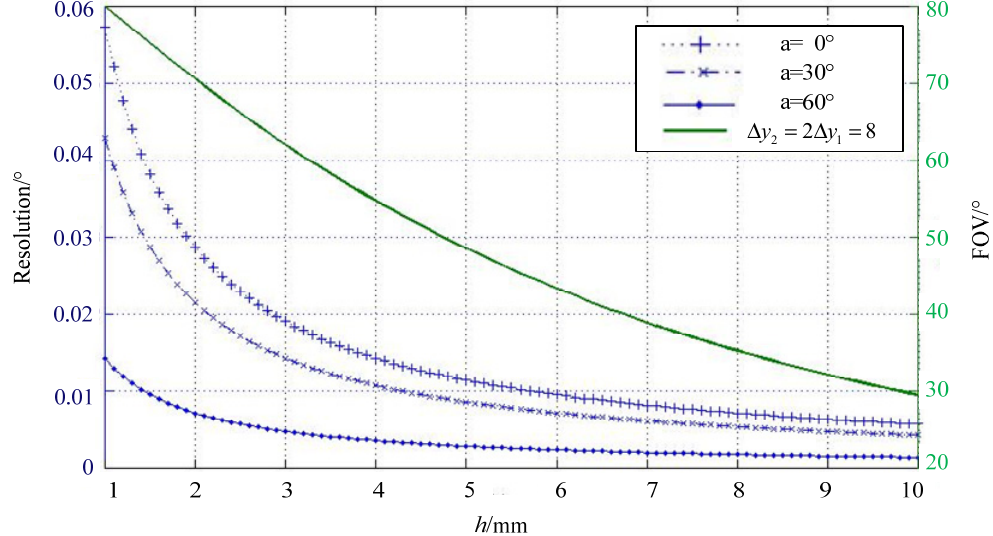
Figure 6. Simulation of resolution and FOV subject to h.